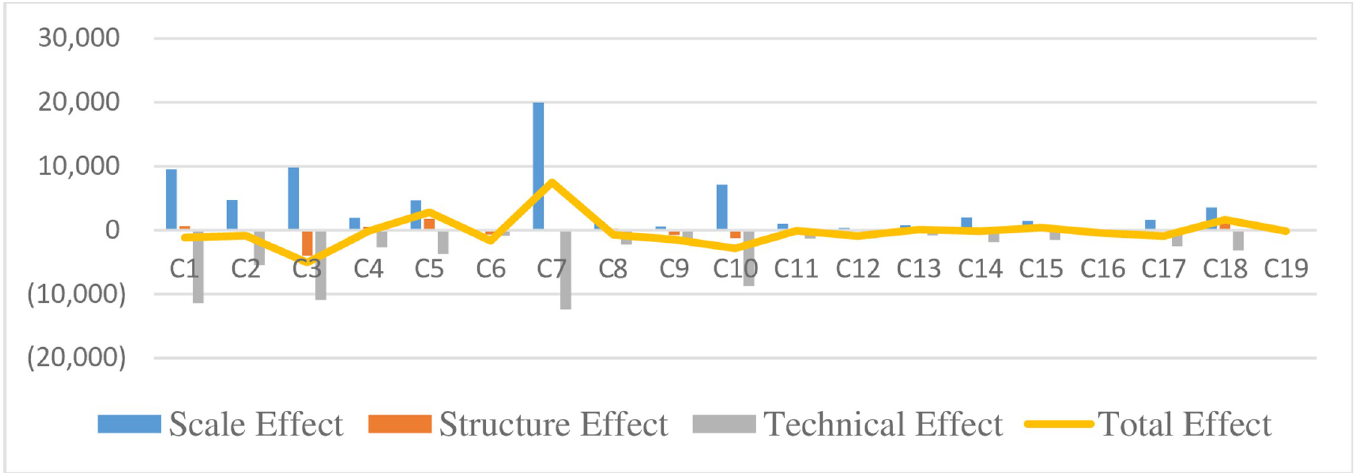
Fig 3. Decomposition of factors affecting wastewater emissions (unit: 10,000 tons).